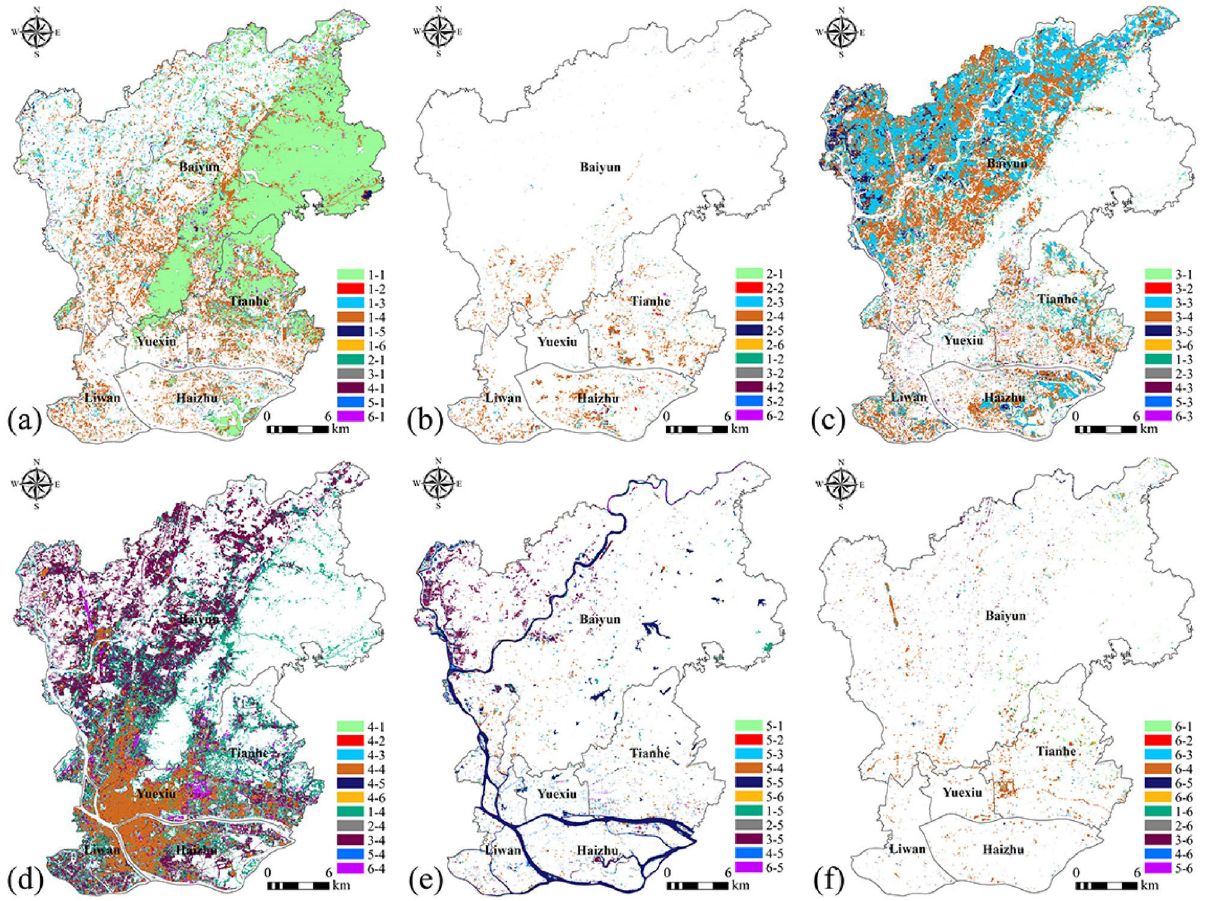
Figure 5. Spatial conversion change of LULC types in the main urban area of Guangzhou between 1987 and 2017. ( a ) forest, ( b ) grassland, ( c ) cultivated land, ( d ) built-up area, ( e ) water body, ( f ) bare land. (Software: Arc Map 10.5.0, http://www.esri.com). 1, 2, 3, 4, 5 and 6 refer to forest, grassland, cultivated land, built-up area, water body and bare land,